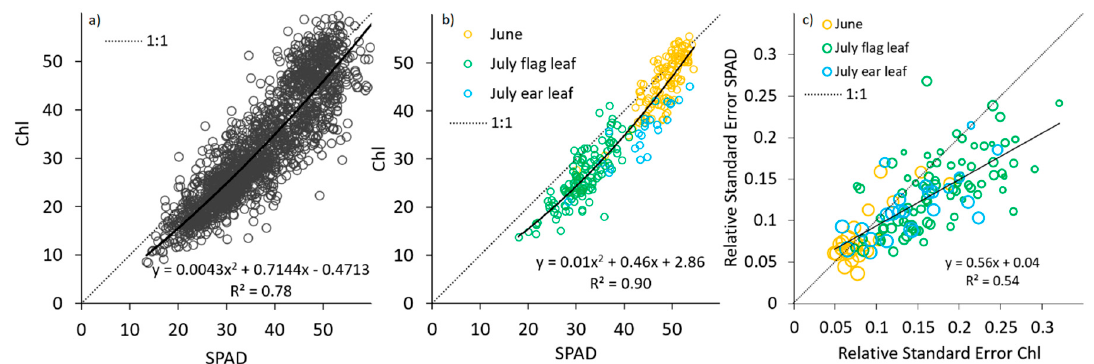
Figure 1. The relationship between the average measurements (from 15 samples) obtained with SPAD and Dualex (Chl) in June on the last completely expanded leaf (N = 120), in July on the flag leaf (N = 120) and in July on the ear leaf (N = 24) from Experiments 1, 2 and 3. ( a ) Including all individual measurements (N = 3960); ( b ) Aggregating by plot, date and leaf (N = 264); ( c ) Comparing the relative standard error observed in the plot (larger circles represent larger original average values; N = 264).